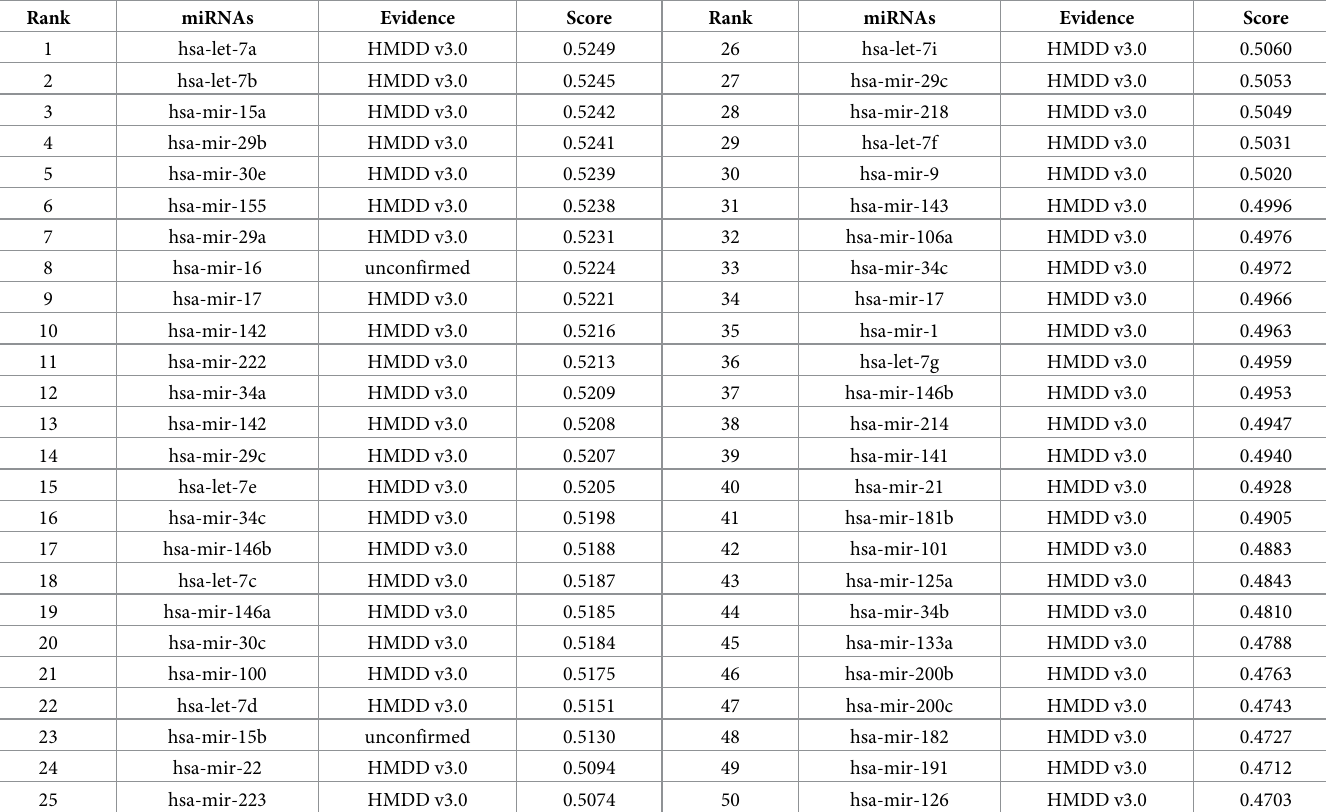
Table 4. Validation results of predicted associations for lung neoplasms as an unknown